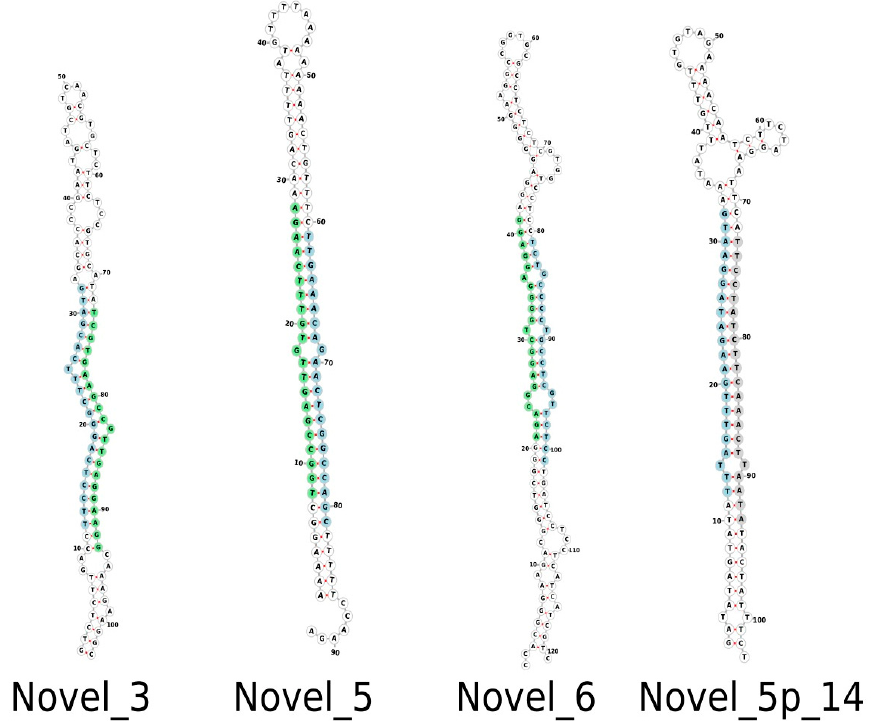
Figure 2. Examples of predicted hairpin secondary structures in selected novel Musa acuminata var. Calcutta 4 miRNAs. Secondary structures were determined using the program Forna. Mature sequences are highlighted in light blue. Star sequences are highlighted in light green. A putative star sequence is highlighted in light grey.